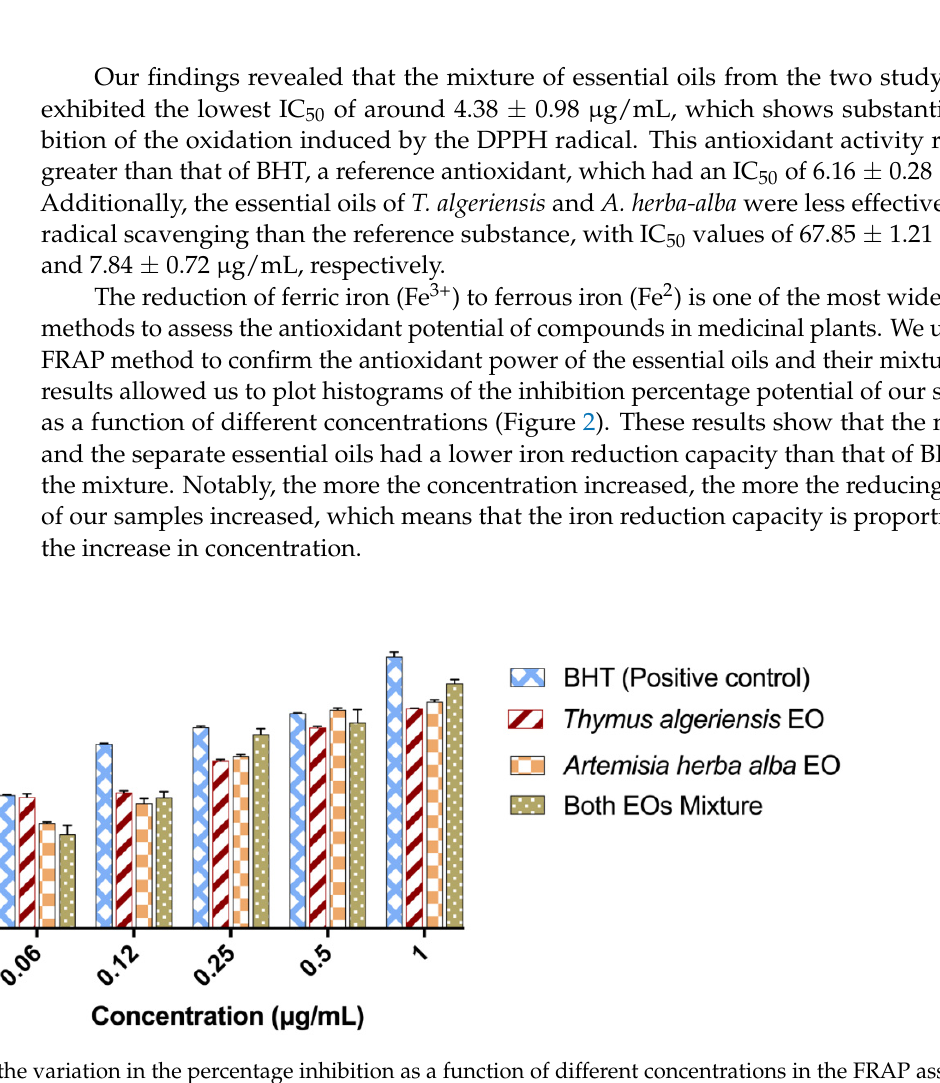
Figure 1. Antioxidant activity profile of butylhydroxytoluene (BHT), T. algeriensis and A. herba-alba essential oils and their mixture (50:50) in the DPPH test. The values are expressed as the mean ± standard error of the mean with n = 3.